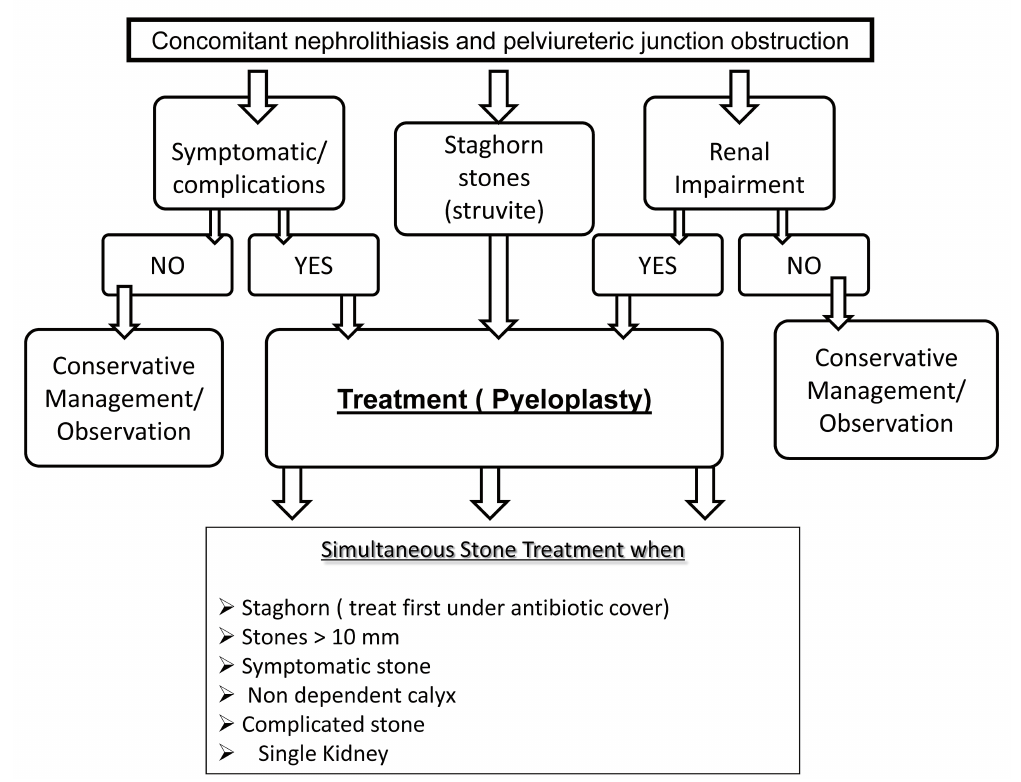
Figure 1 - Suggested algorithm for the management of established PUJO and concomitant